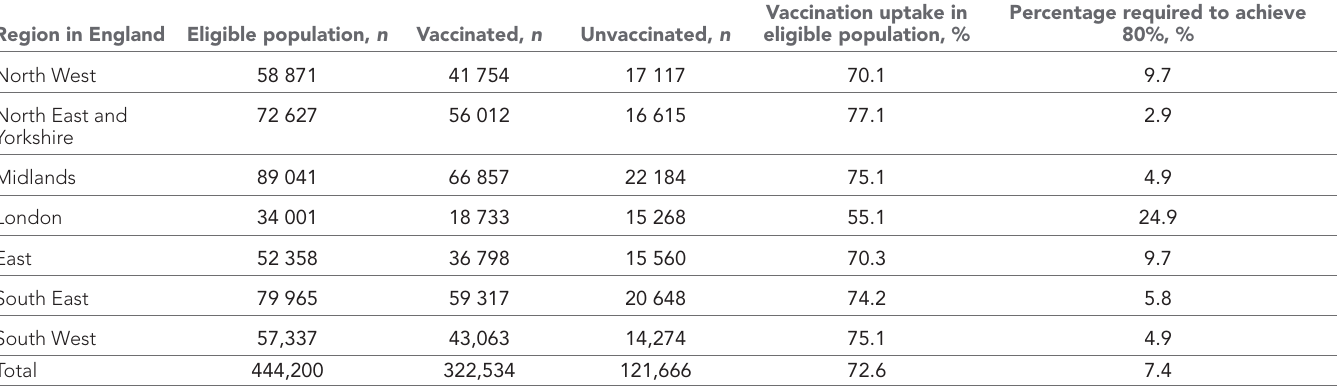
Table 1 Summary COVID- 19 vaccination figures for care home workers by region in England immediately preceding the Roadmap out of COVID-19 Lockdown implementation